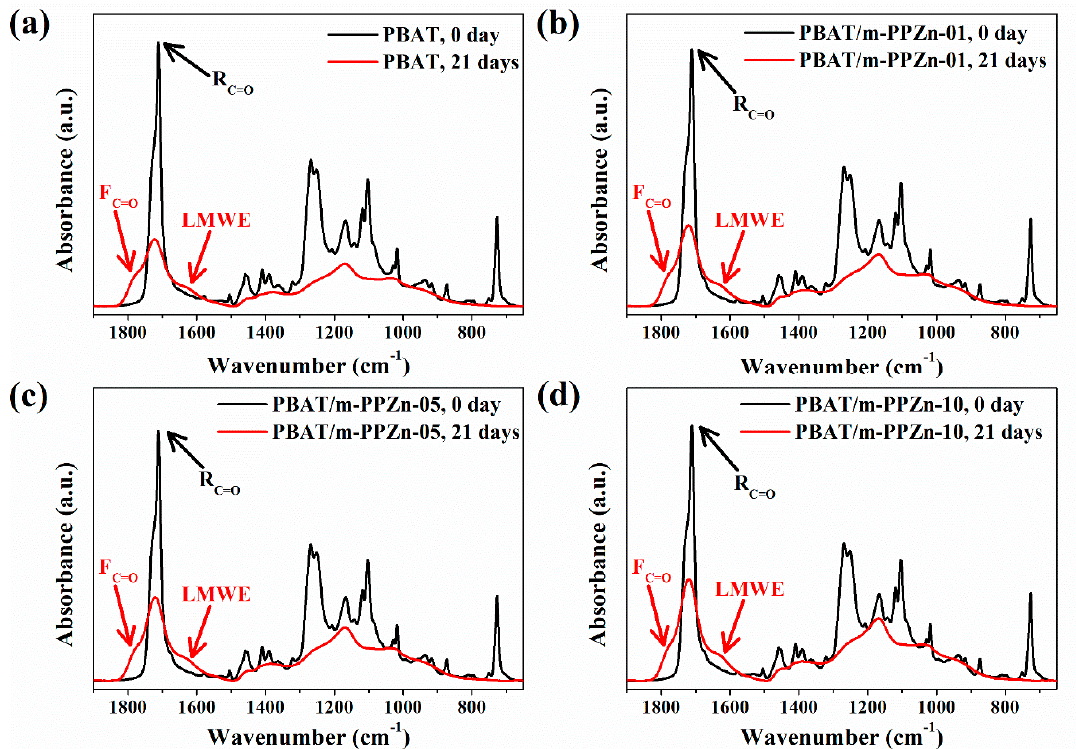
Table 1. The decrease in the F C = O / R C = O value with increasing m-PPZn content demonstrates that the m-PPZn retards the photodegradation of the PBAT.